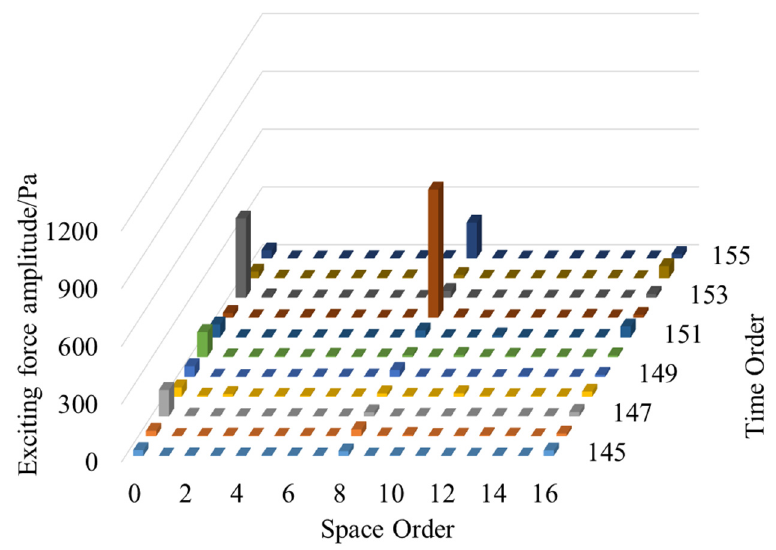
Figure 6. Two-dimensional Fourier decomposition results of the excitation force of the skewed slot motors at 1000 rpm.